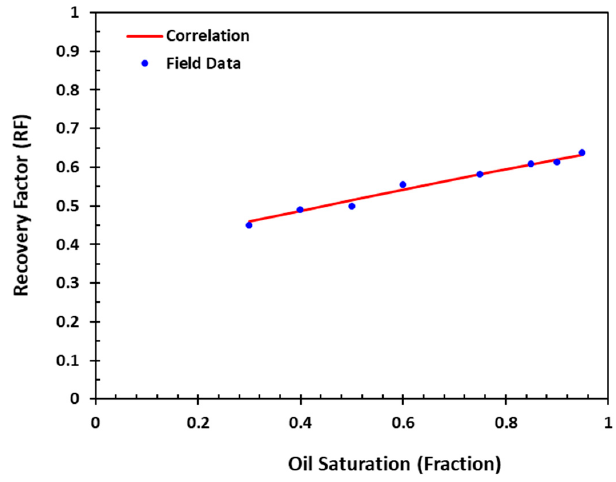
Figure 16. RF vs. oil saturation for the database analyzed.